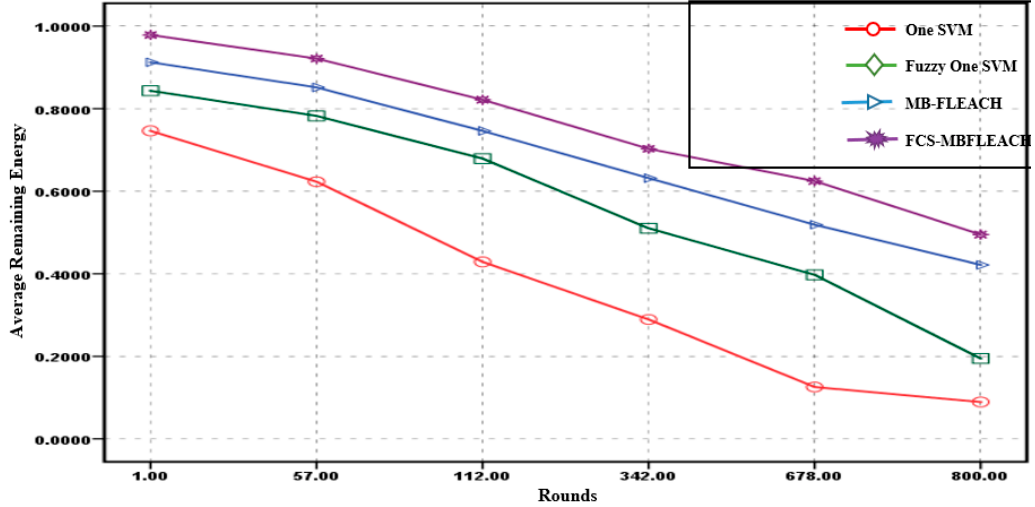
Figure15. Averageremainingenergyforfaultdetectionmethodsindi ff Figure 15. Average remaining energy for fault detection methods in different rounds for the first scenario.